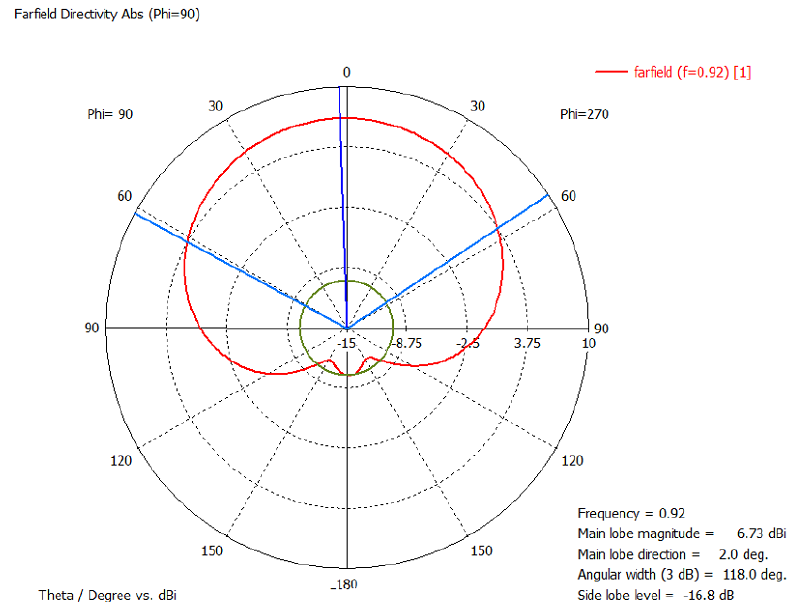
Figure 10. Simulated radiation pattern of YZ plane.